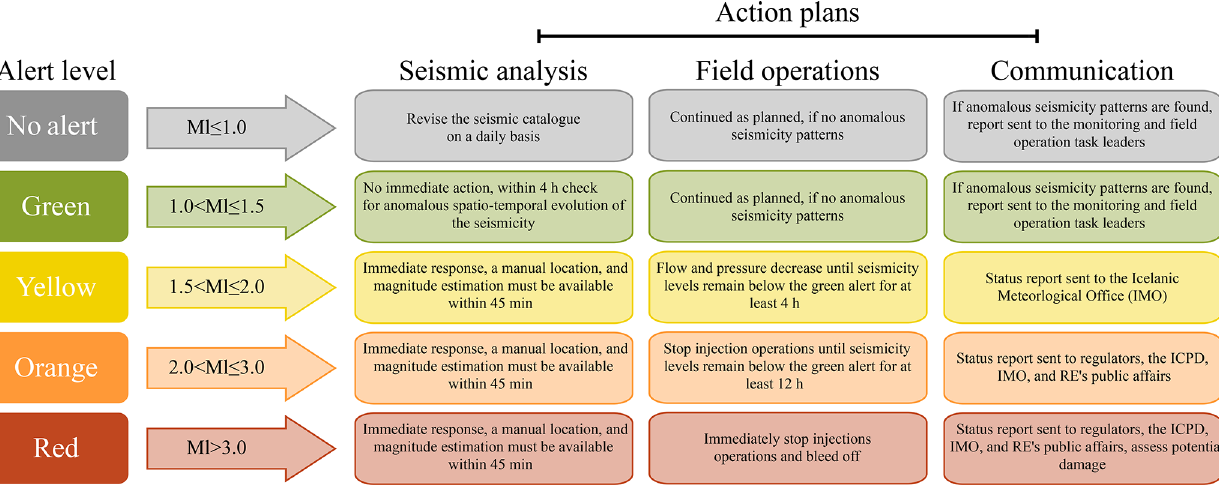
the early stage of the cyclic stimulation, and injection is in- creased carefully until at least a few events are detected and